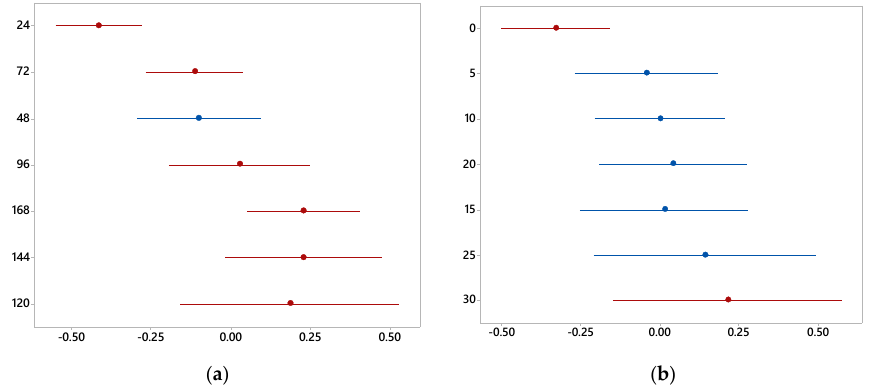
Figure 8. Comparison plots of means for pH of the system in function of different levels of curing time ( a ) and NaCl concentration ( b ).